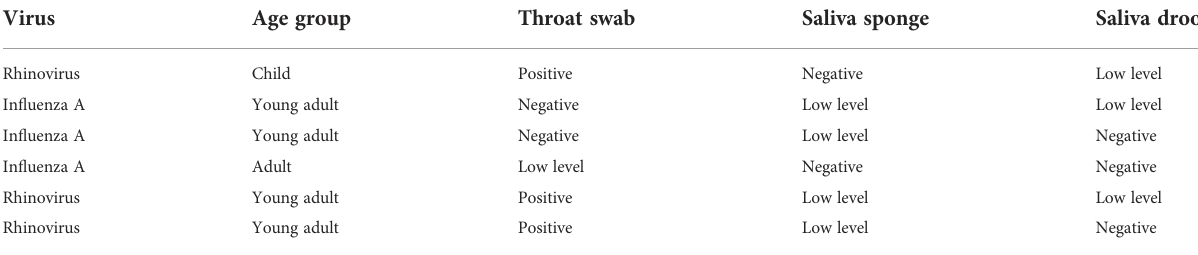
TABLE 4 Stage 2 virology